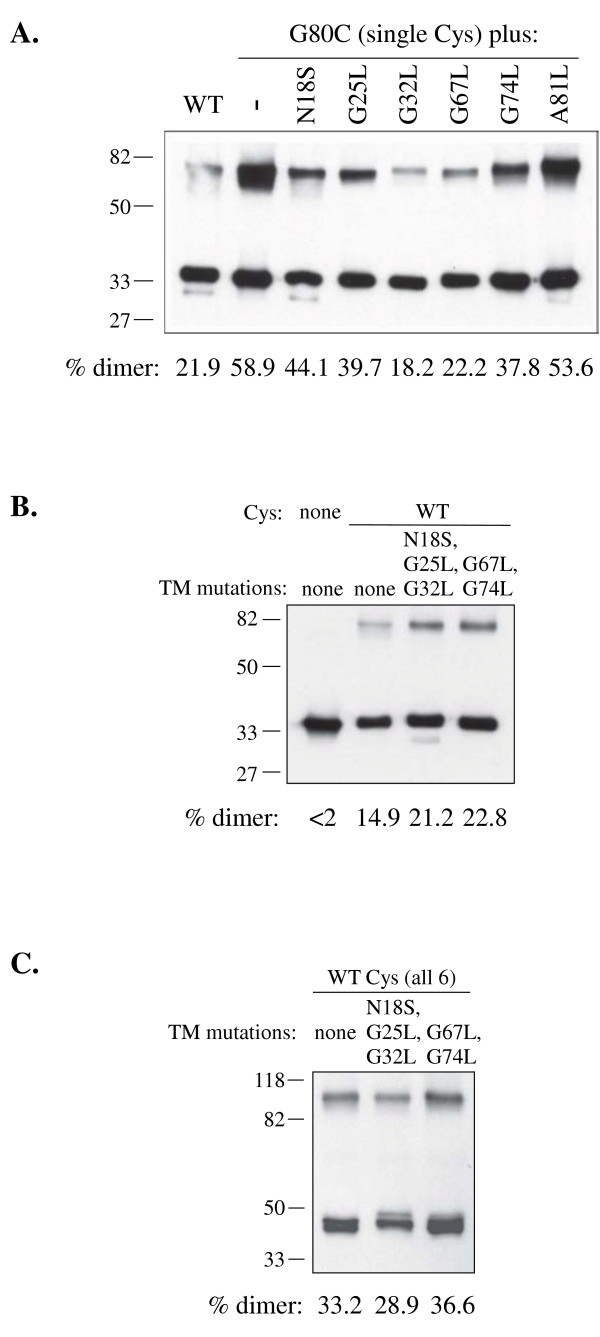
Effect of mutations in conserved TM1 and TM2 residues on CD9 cross-linking. RD cells were transfected with constructs encoding the following fusion proteins: panel A, CD9 TM(1+2)-GFP, either wild-type or single-cysteine G80C mutant, which also carries TM1 and TM2 substitutions indicated; panel B, CD9 TM(1+2)-GFP with no cysteines or wild-type cysteines (Cys9,78,79) plus TM1 and TM2 mutations; panel C, full-length CD9-GFP with TM1 and TM2 mutations indicated. The proteins were cross-linked and analyzed by GFP Western as in Figure 7. % dimer was calculated as for Figure 7.